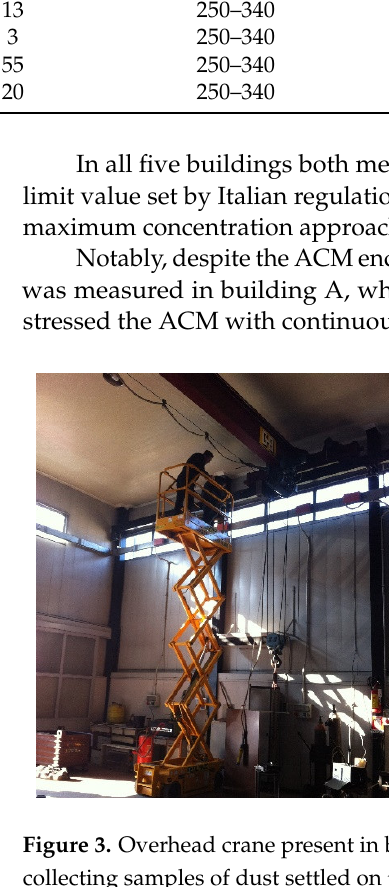
( b ) Figure 4. SEM image of airborne amosite fibers collected in building A on polycarbonate filter ( a ) and related EDS spectrum ( b ). The maximum concentration of asbestos fibers in the air reached more than 1 f/L in the two buildings, B and C, where asbestos plaster was present and no abatement measures had been taken. Such concentrations were also reached when the friable ACMs were encapsulated (buildings D and E) and small cracks had formed in the insulation material. After detec- tion and repair of damage to the encapsulant, the airborne asbestos fiber concentration was below the detection limit, corresponding to 0.4 f/L for a filter reading area of 1 mm 2 and a sampled air volume of 3000 L. This value represents the limit below which, for a Poisson distribution, with 95% probability, the true concentration is found when no fiber is detected during SEM analysis [20]. 3.2. Buldings in Which Non-Friable ACMs Were Present In public office buildings with non-friable ACMs, 198 air samples were collected and 87% of the measured airborne asbestos fiber concentrations were below the detection limit. In 11% of the measurements, airborne asbestos concentrations were above 0.4 f/L and below 2 f/L. Finally, 2% of the measurements showed concentrations above 2 f/L. The air samples having the highest concentrations came from one building in which ACMs were highly deteriorated. The results for public office buildings with non-friable ACMs are shown in Figure 5.